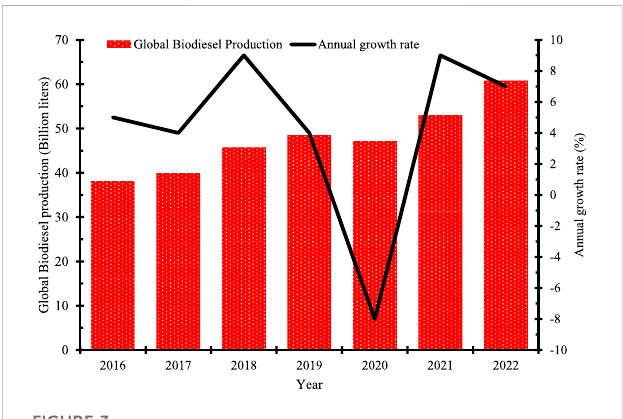
FIGURE 3 Global biodiesel production and growth rate from 2016 to 2022.